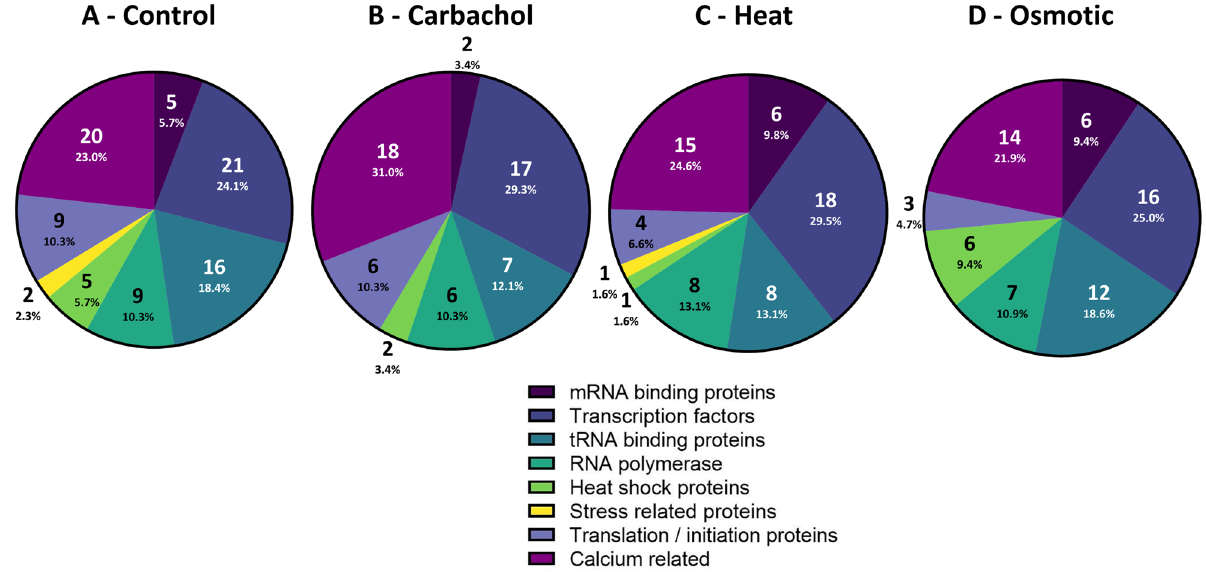
Figure 2. Distribution of Ago2 stress granule proteins under different stress. PC12 cells over expressing eGFP- Ago2 were exposed to (A ) no stress, ( B ) carbachol activation of Gαq (10 min, 5 µM), ( C ) heat shock (1 h, 42 °C), or ( D ) hypo-osmotic stress (150 mOsm, 5 min). Ago2 particles were pulled down for cytosolic fractions using a monoclonal GFP antibody. Purified stress granules were then subject to mass spectrometry analysis and